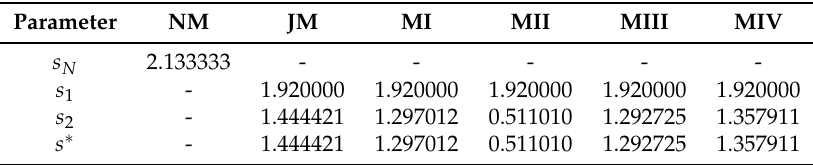
Table 3. Numerical results for Example